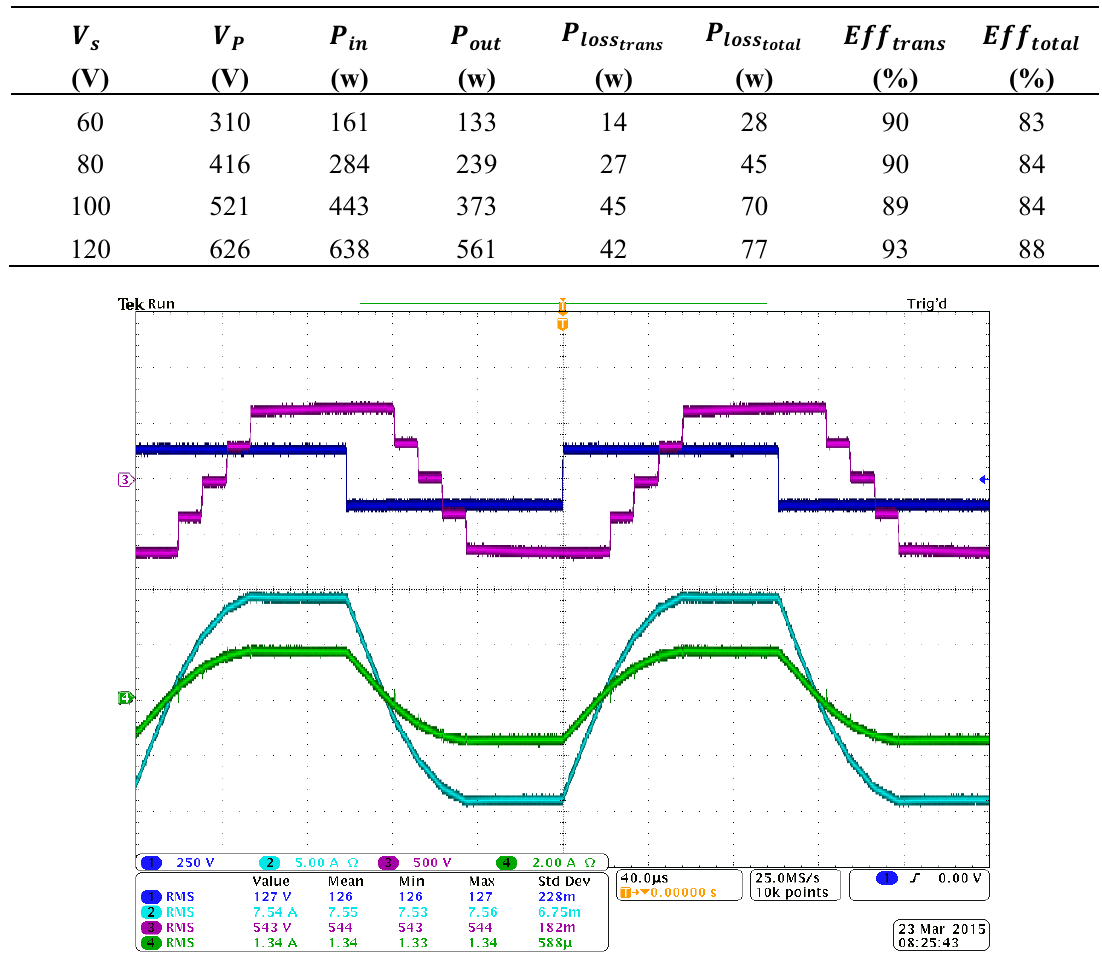
, 5L voltage (cid:1874) and current through the 2L and (cid:3002)(cid:3003) (cid:3028)(cid:3029) ; where (cid:1848) and (cid:1861) = 125 V, (cid:1848) = 650 V, (cid:1866) = 5.71, (cid:2009) = 10 (cid:2868) , (cid:3013) (cid:3291)(cid:3293)(cid:3284) (cid:3013) (cid:3294)(cid:3280)(cid:3278) (cid:3046) (cid:3017)